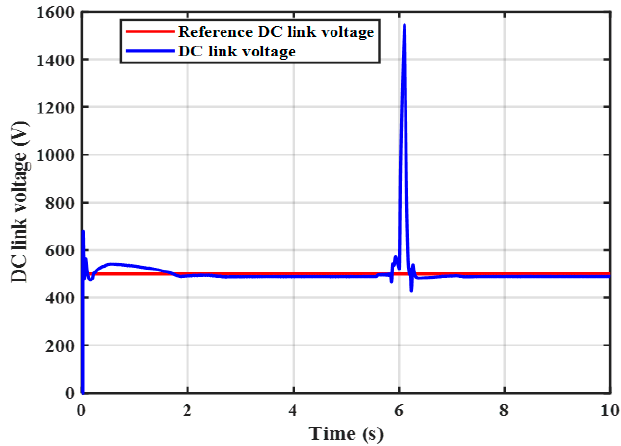
Figure 23. DC link voltage with LLLG fault.